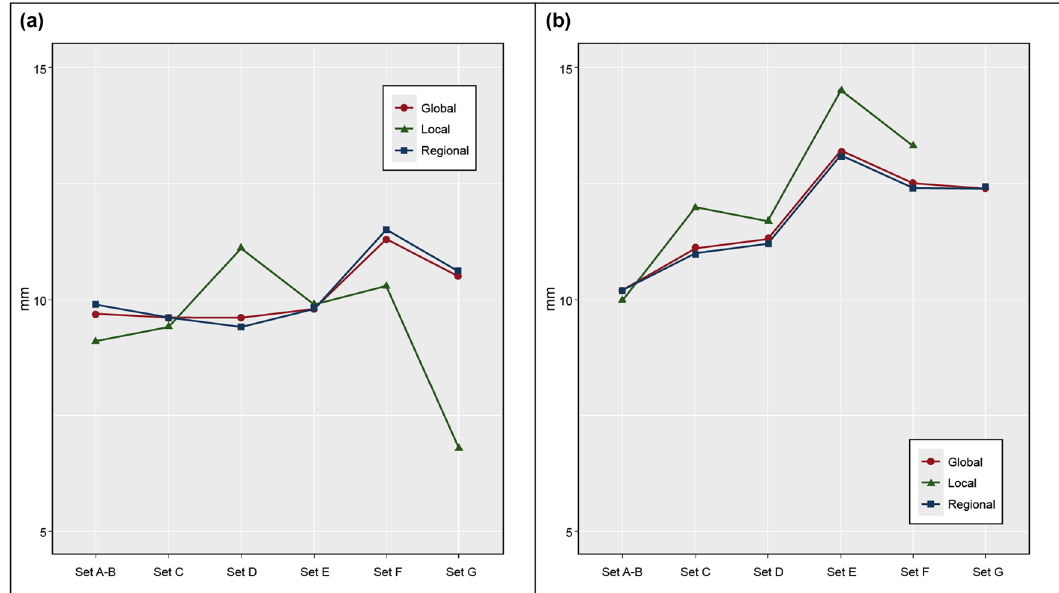
Figure 9: Evolution of the average widths of the fi rst - line laminar blanks ( a ) and arrowheads ( b ) according to the raw mate - rials